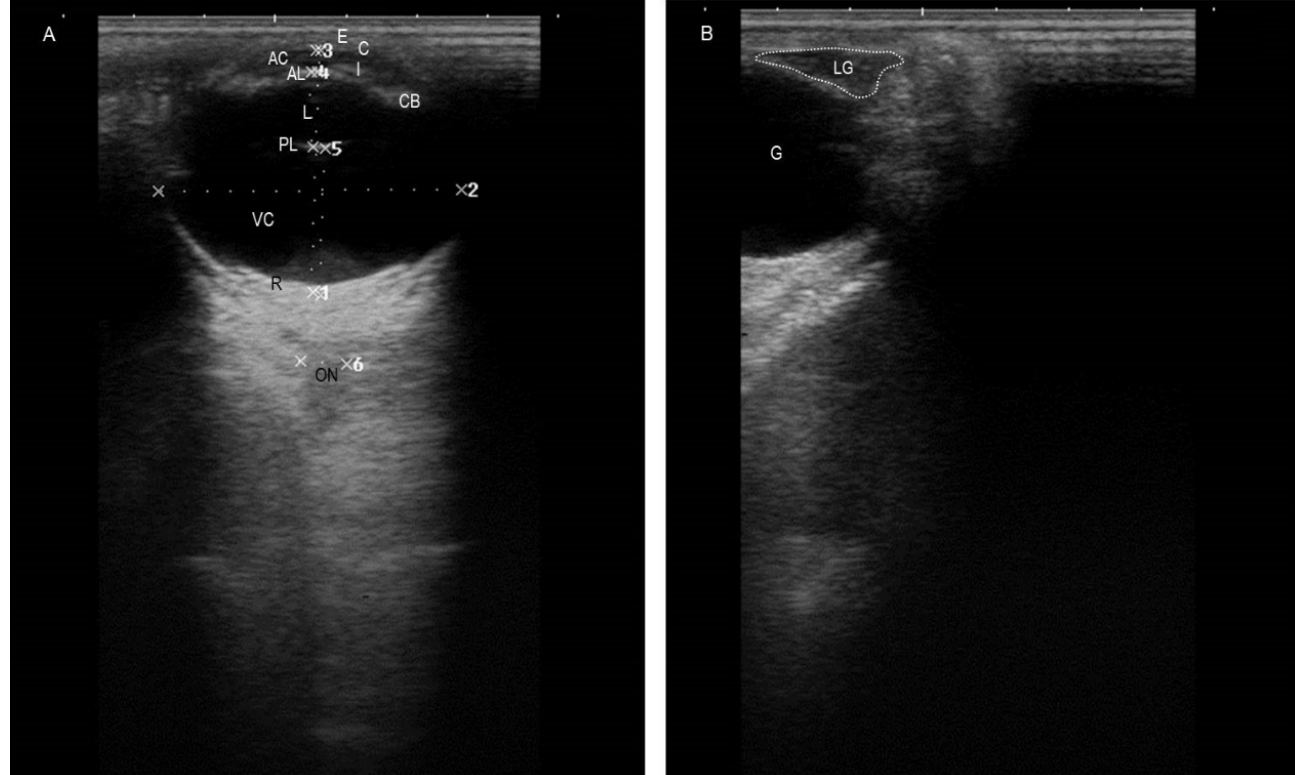
Figure 1. ( A ) A representative ultrasonogram depicting normal eye structures and their measure- ments in a healthy adult donkey. ( B ) A representative ultrasonogram demonstrating shape and location of the normal LG of a healthy adult donkey. E: eyelid; C: cornea; AC: anterior chamber; AL: anterior lens; L: lens; PL: posterior lens; I: iris; CB: ciliary body; VC: vitreous chamber; R: retina; ON: optic nerve; G: globe; LG: lacrimal gland.